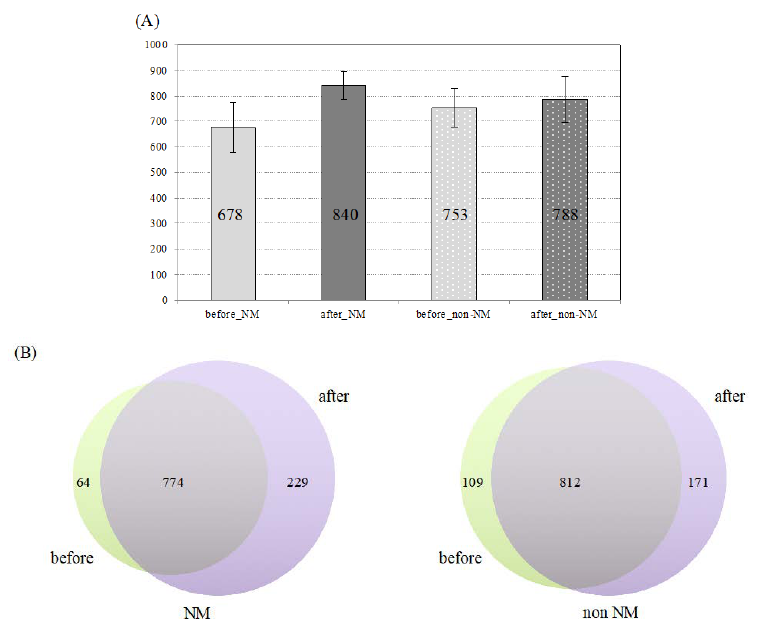
Figure 3. Protein identification of each group. ( A ) Average protein identification number with the non redundant results from each groups with a < 0.05 significant threshold. The error bar indicates standard deviation. ( B ) Comparison of unique and shared proteins both before and after bathing in a sauna. The left Venn diagram indicates a nano mist sauna and right panel shows a non nano mist sauna (detailed information can be found in the supplementary table S1). Healthcare 2019 , 7 , x